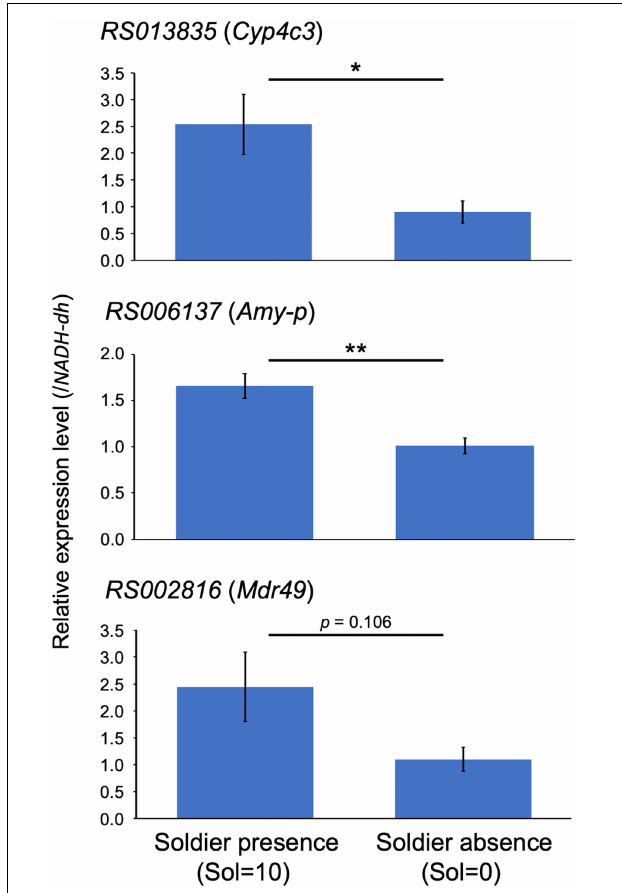
FIGURE 3 | Quantitative real-time PCR expression levels of the three genes (mean ± S.D., biological quintuplicates) in the 40 µ g juvenile hormone (JH) III-treated workers with 10 soldiers (Soldier presence, “Sol = 10”) and 0 soldiers (Soldier absence, “Sol = 0”). Each value was normalized to the expression levels of NADH-dh ( Supplementary Table 8 ). Asterisks above the bars indicate significant differences (* P < 0.05, ** P < 0.01; Welch’s t